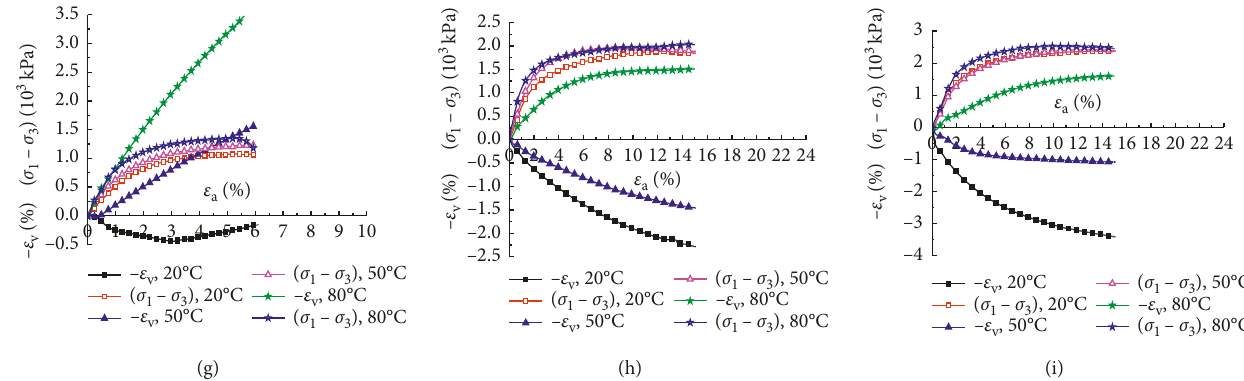
Figure 5: The relationship curves of ( σ confining pressures, and temperatures. (a) ρ � 5%, σ � 2000kPa. (d) ρ � 1.6g/cm 3 , w � 15%, σ 3 d � 1.6g/cm 3 , w � 25%, σ 2000kPa. (g) ρ d